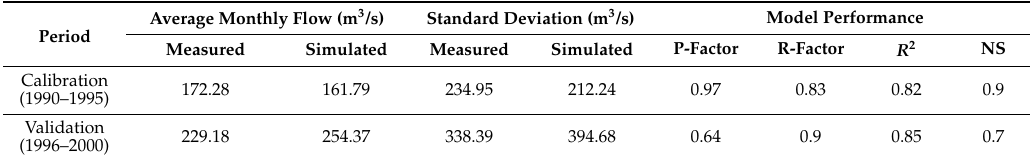
Table 7. Model performance During the Period